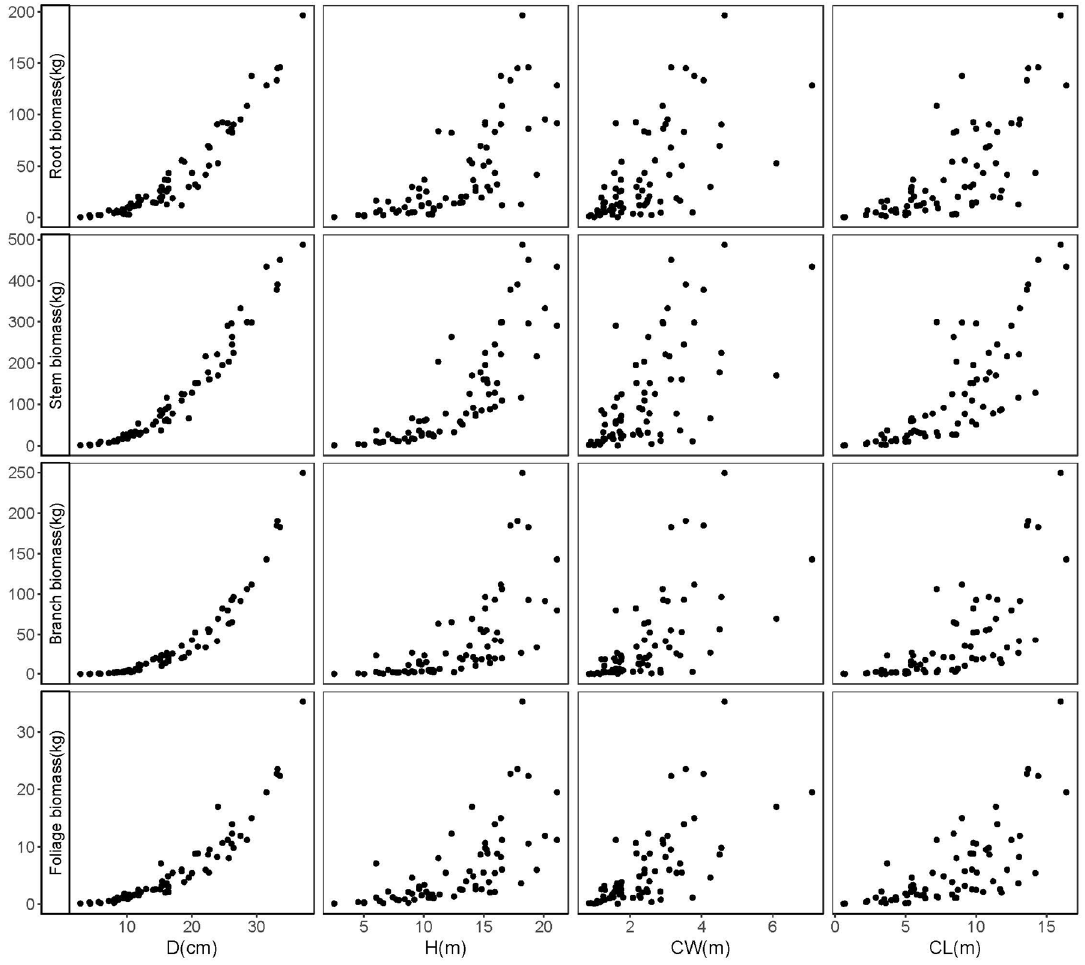
Figure 2. Relationships between diameter at breast height (D), tree height (H), crown width (CW) and crown length (CL), and tree component biomass